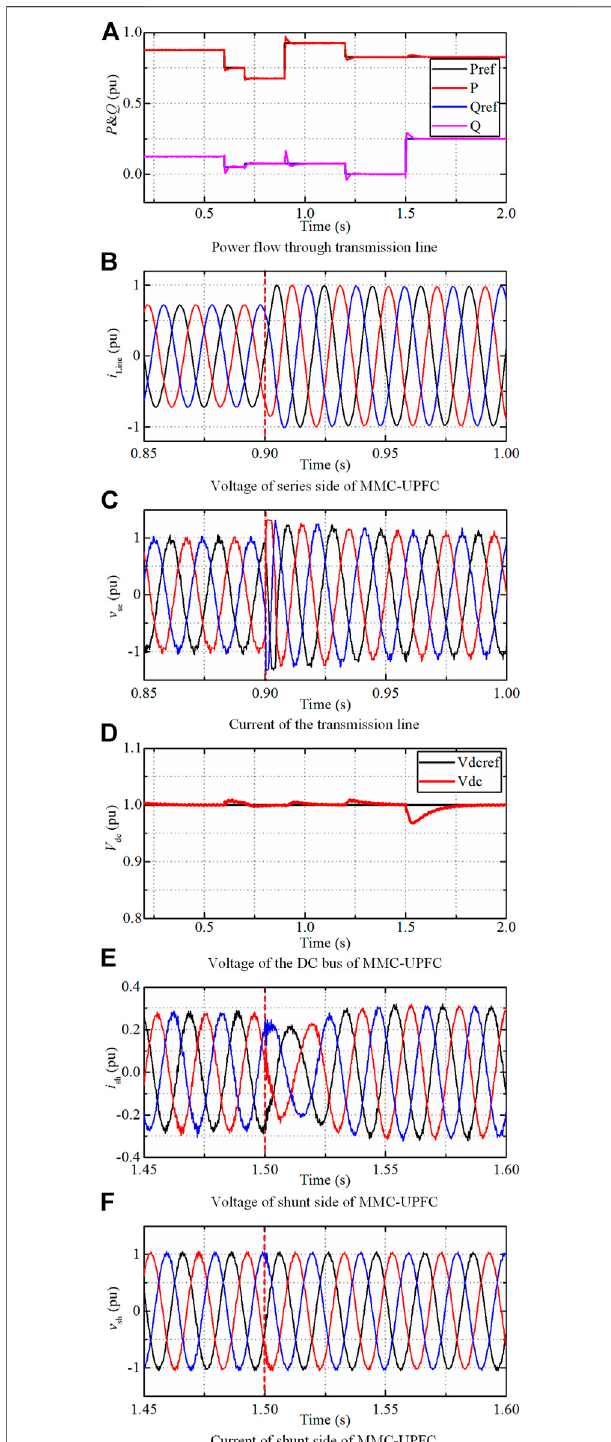
FIGURE 8 | Simulation results of the proposed passive-sliding mode control